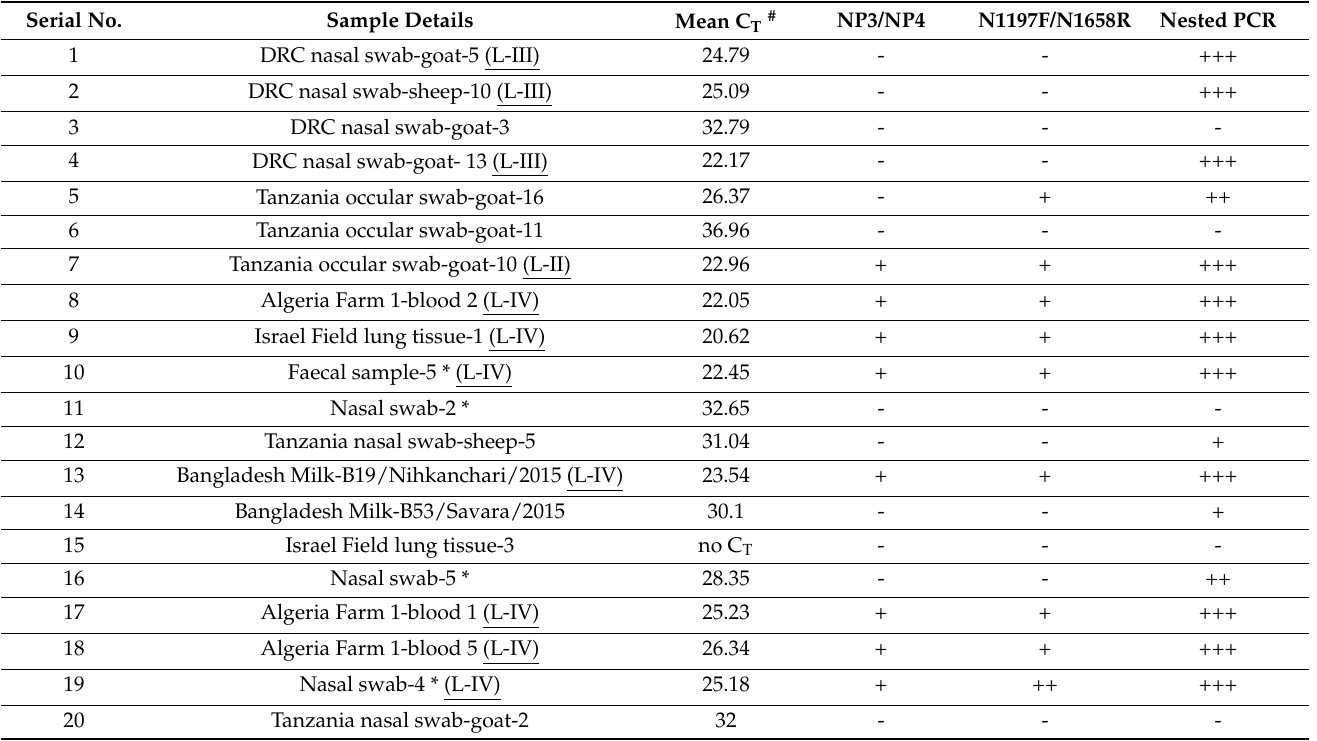
Table 1. Virus isolates and clinical samples used for the development and evaluation of the nested PCR. Samples 1–21 were clinical samples either collected from the field (Algeria, Bangladesh, Democratic Republic of Congo (DRC), Israel and Tanzania) or experimental samples. The samples with an asterisk (*) at the end of their name (10–11, 16, 19 and 21) were collected from goats experimentally infected with PPRV (Morocco/2008) at The Pirbright Institute (TPI). Samples 22–26 are environmental samples collected from a goat market in Nepal. Samples 27–33 are cell-culture grown PPR viruses comprising four lineages. The lineages of the PPR viruses are shown in parenthesis under sample details wherever applicable. The lineages of the field samples identified by sequencing the nested PCR products in this study are underlined. # indicates mean C T -values obtained from real-time RT-PCR (RT-qPCR) assay. -: negative; + and ++: weakly and moderately positive, respectively, but nucleotide (nt) sequencing was not possible from these products; +++: strongly positive and nt sequence was generated from these